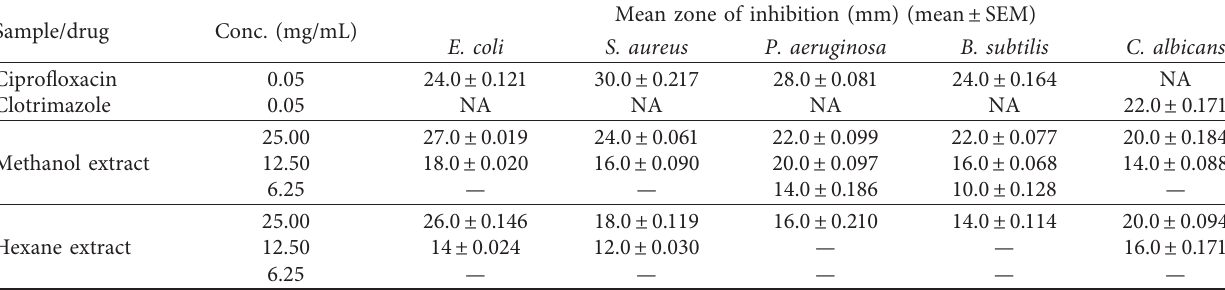
Table 6: Mean zones of inhibition (ZI) of methanol and hexane extracts of V. camporum and ciprofloxacin and clotrimazole standards. Sample/drug